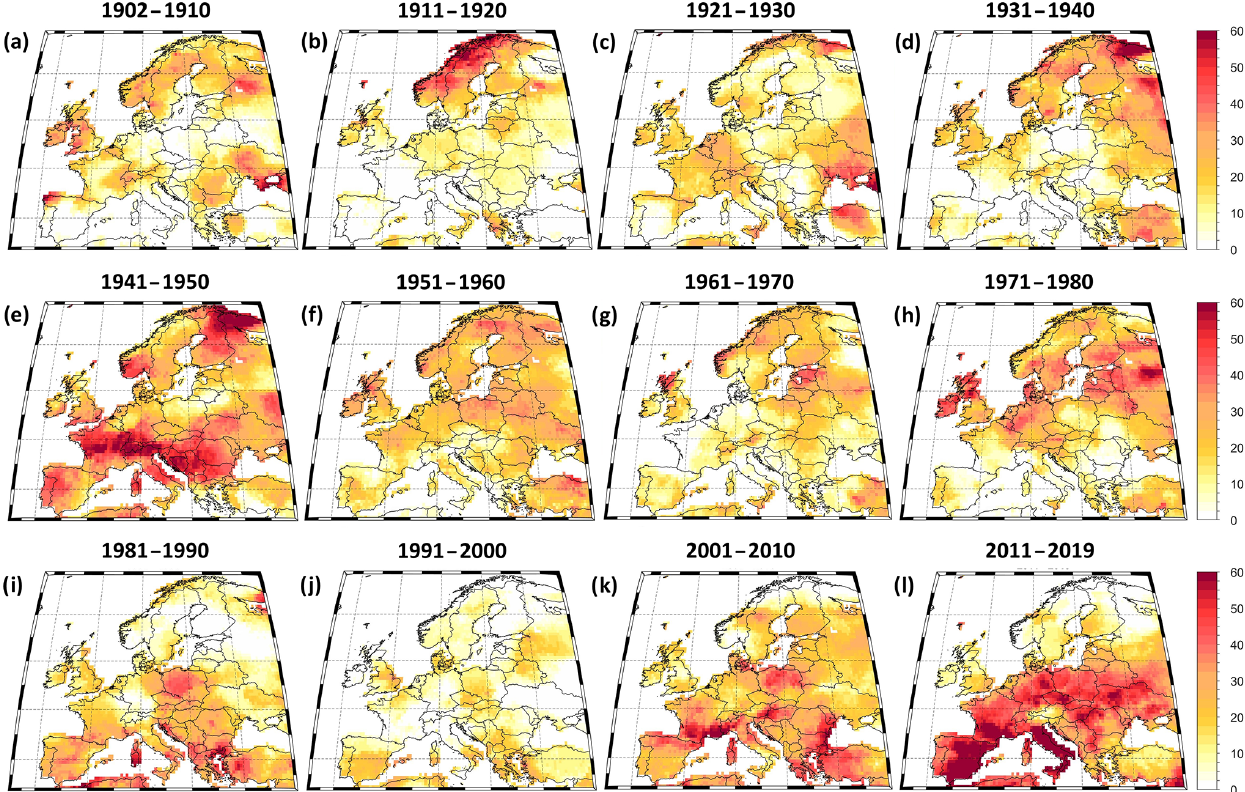
Figure 5. Decadal frequency of drought duration for moderate drought (SPEI12 between − 1 . 0 and − 1 . 5). (a) 1902–1901, (b)